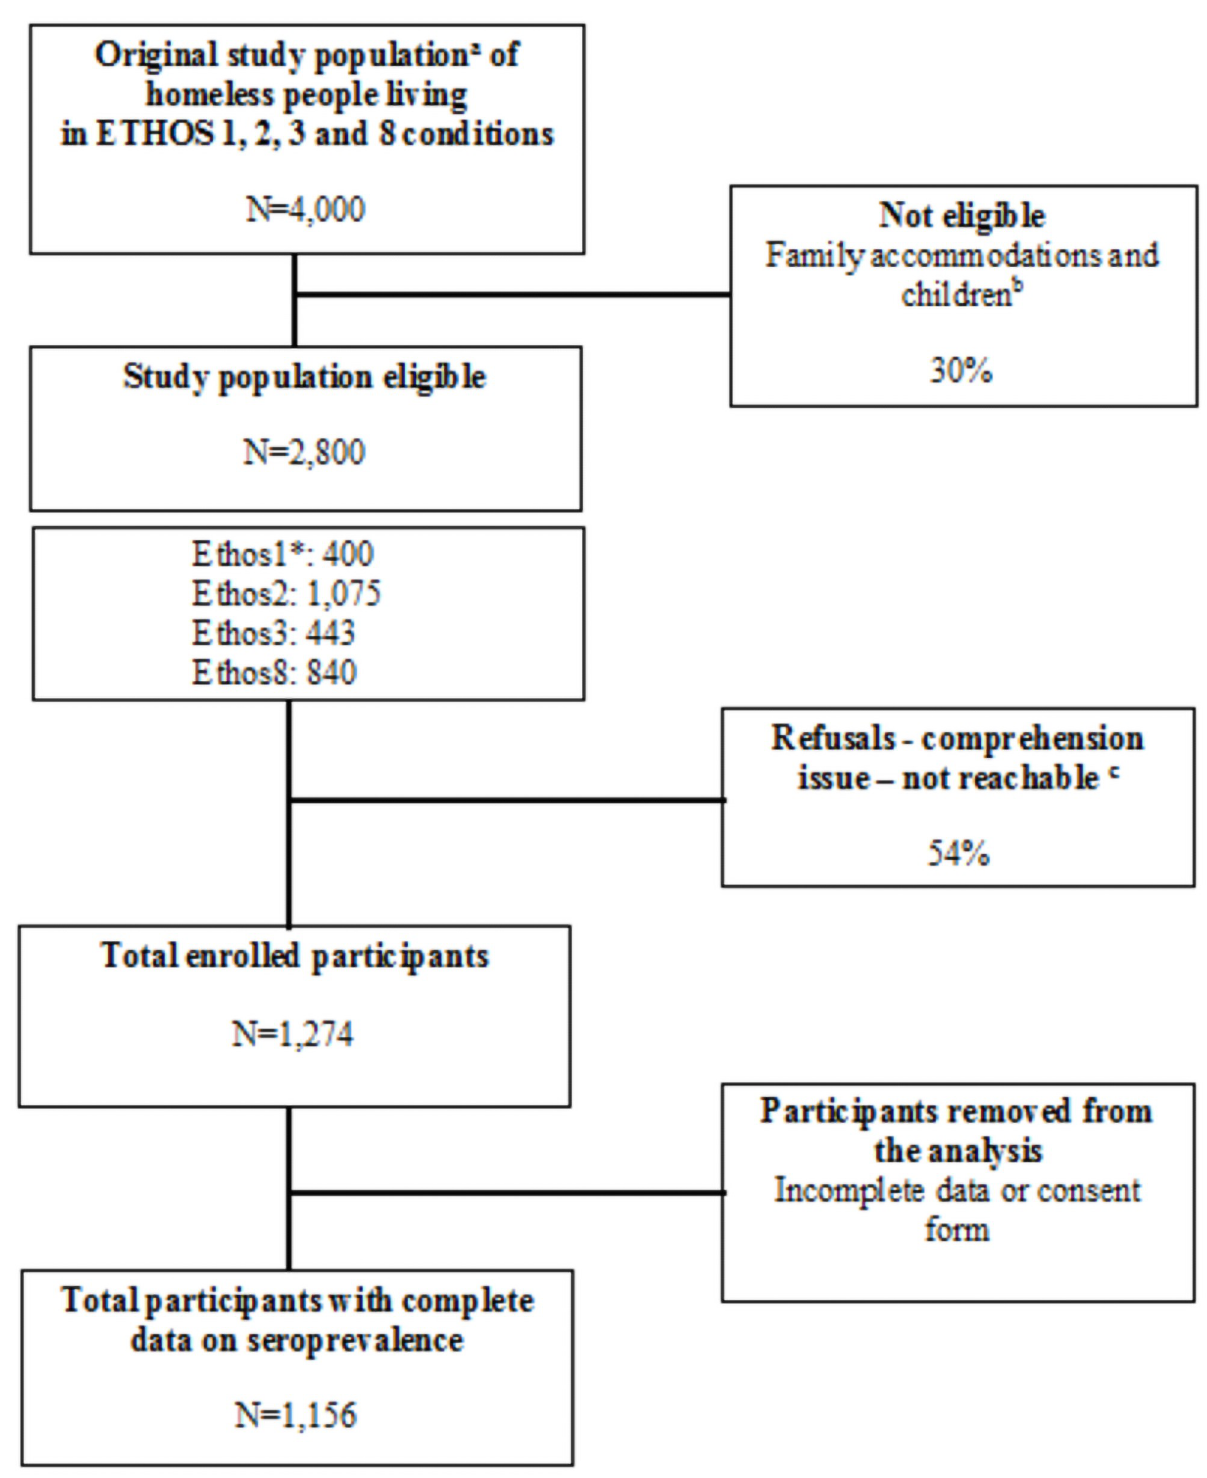
Fig 2. Flow chart of the SARS-CoV-2 seroprevalence study among people experiencing homelessness, Marseille, France. a: Although comprehensive homelessness prevalence data for Marseille are still lacking, we used data from local Integrated Reception and Orientation Service (IROS–SIAO in French) for emergency and transitional accommodations, and estimations of NGOs for slums/squats and streets; b: estimations of NGOs at around 30% of squat inhabitants; c: Reasons for not being included in the study were difficult to distinguished as most of people living in